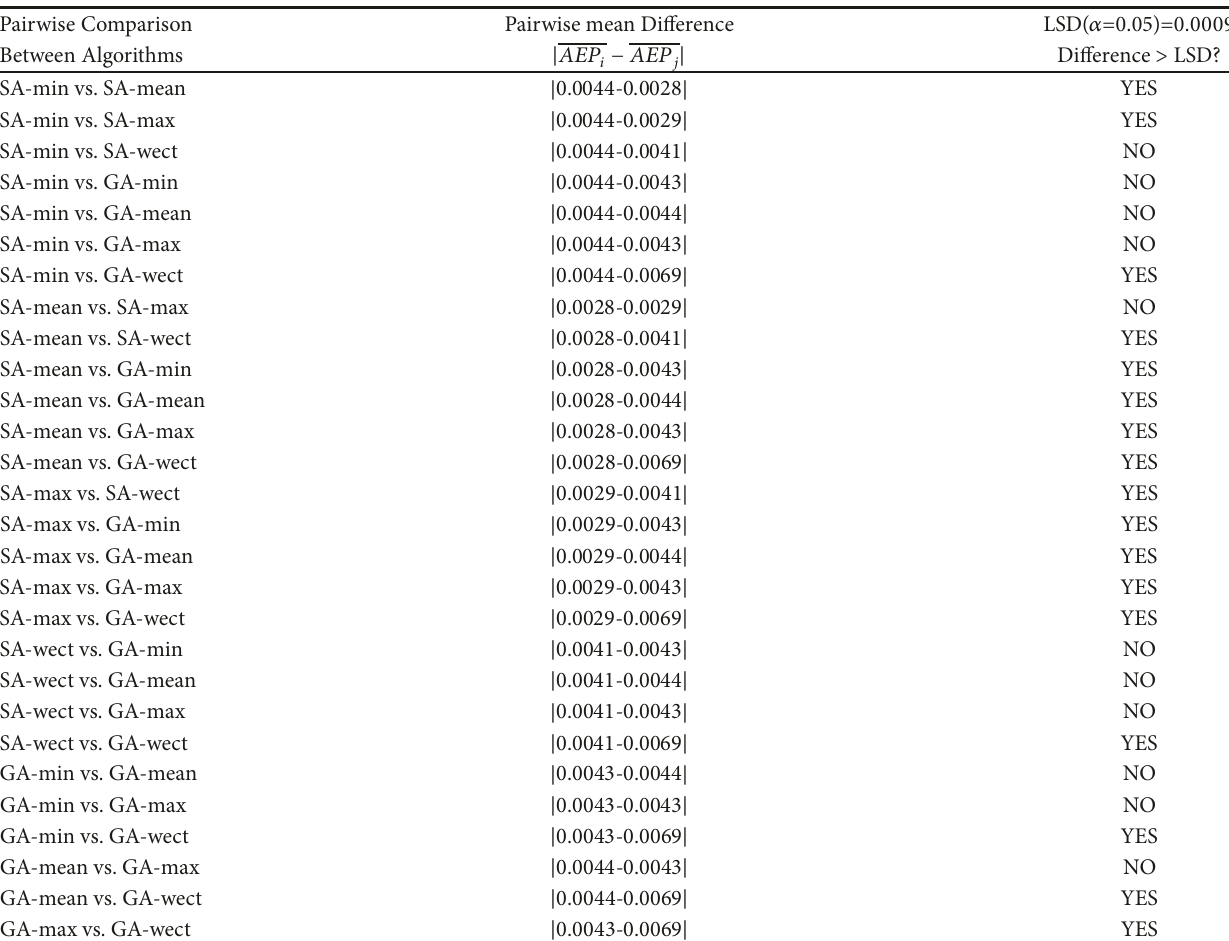
Table 7: Results of Fisher’s LSD for differences among algorithms for small number of